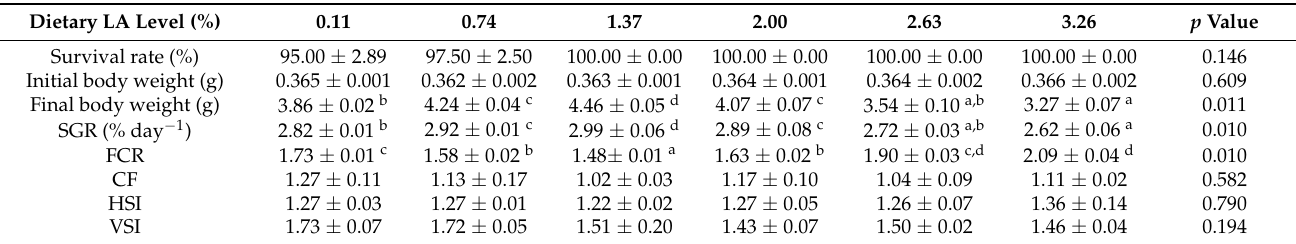
Table 3. Survival, growth performance, and feed utilization of Oncorhynchus kisutch alevins fed with experimental diets with different dietary linoleic acid levels for 12 weeks (means ± SE, n = 3). Dietary LA Level (%)